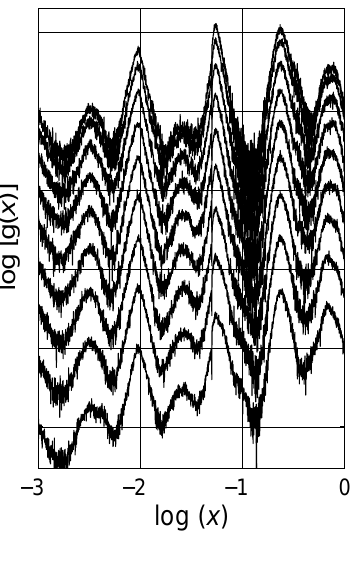
Figure 10 . Spectral density functions of the Landau-Lifshitz/Looyenga equation for nine different concentrations, q = { 0 . 1 , . . . , 0 . 9 } . The data are shifted for better comparison. Six peaks are resolved between x = 10 − 3 and x = 1 . Interestingly, the positions of the most probable spectral parameters of the six are not altered with increasing concentration. Logarithmic scale is base 10.